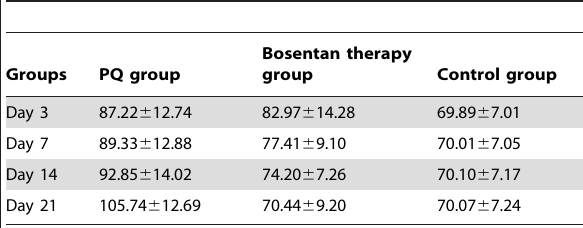
Table 2. Dynamic change of ET-1 in the lungs of the three groups (mean 6 SD, ng/L).